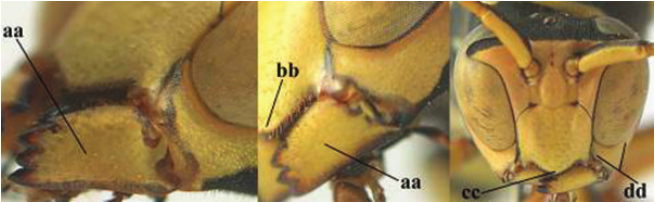
– Mandible comparatively slender and its outer face flat or slightly convex (aa); clypeus flat medio-ventrally (bb), its margin evenly convex or broadly trian- gular (cc); malar space medium-sized (dd) or narrow; social species ..........